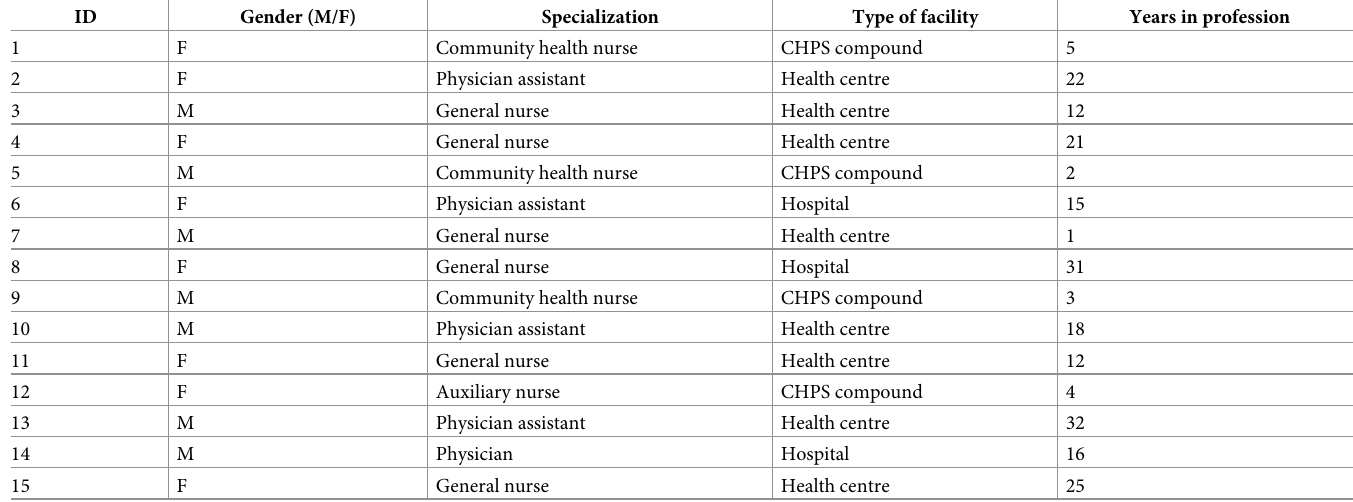
Table 2. Demographics of health care